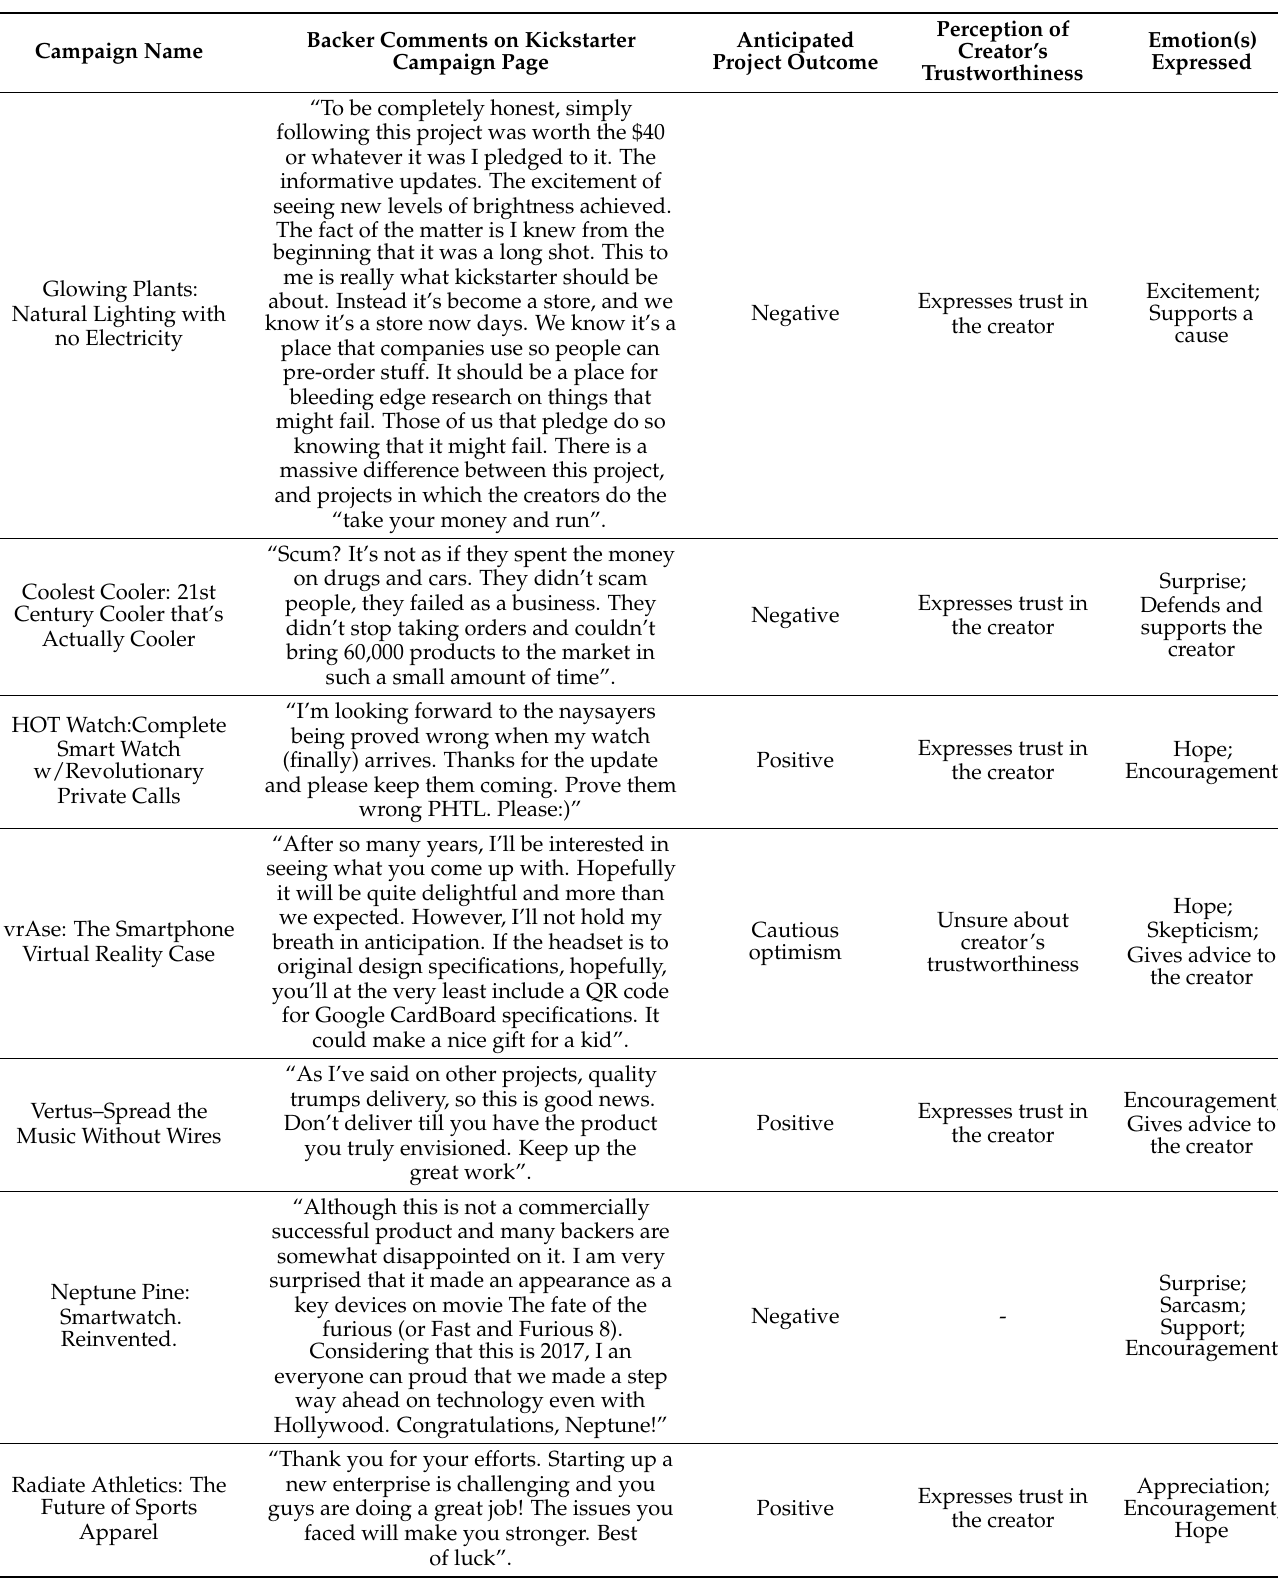
Table 3. An analysis of backers’ comments expressing positive valence in failed RBC projects on Kickstarter (selected